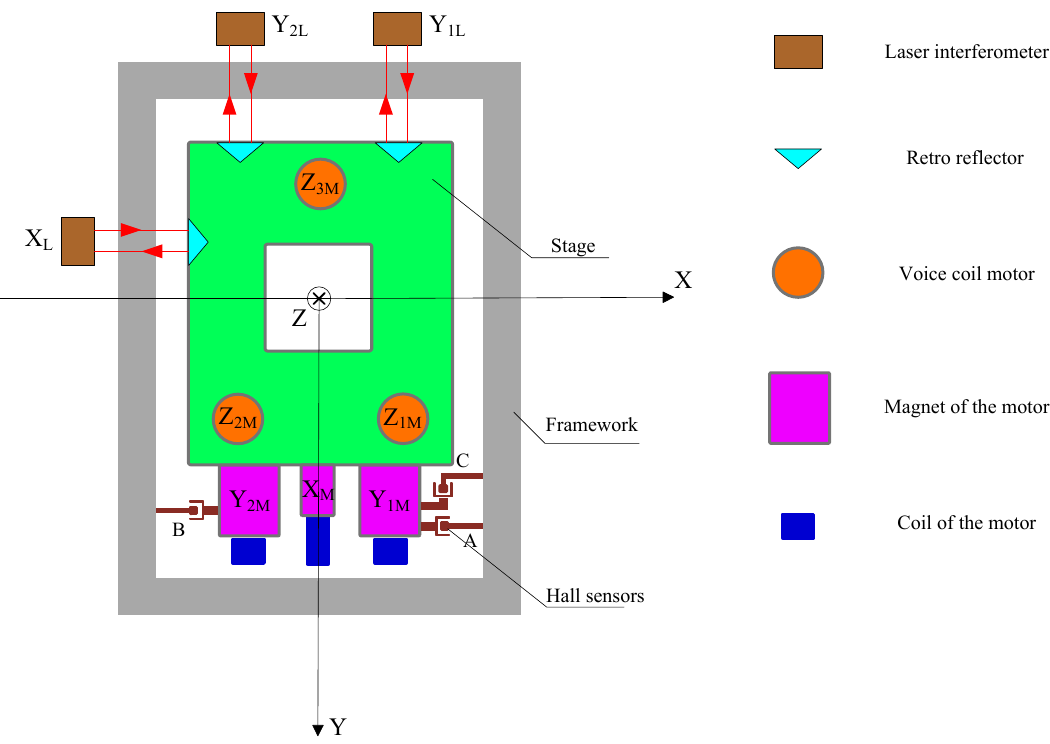
Figure 1. The configuration of the 6-DOF precision stage.